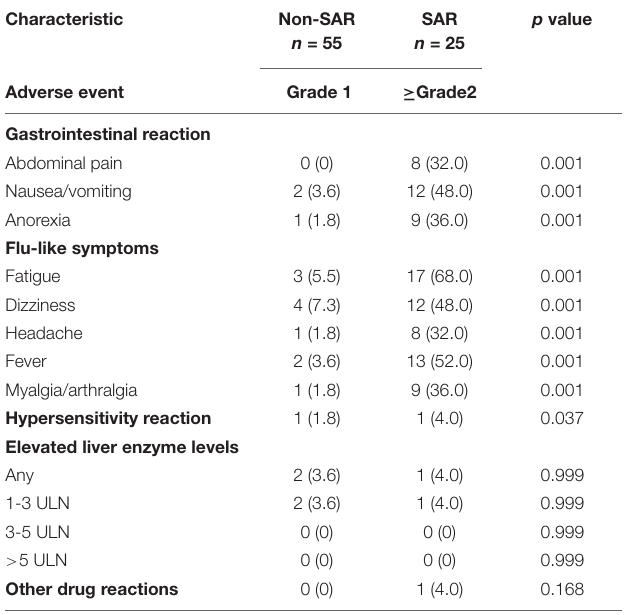
TABLE 2 | List of adverse events.